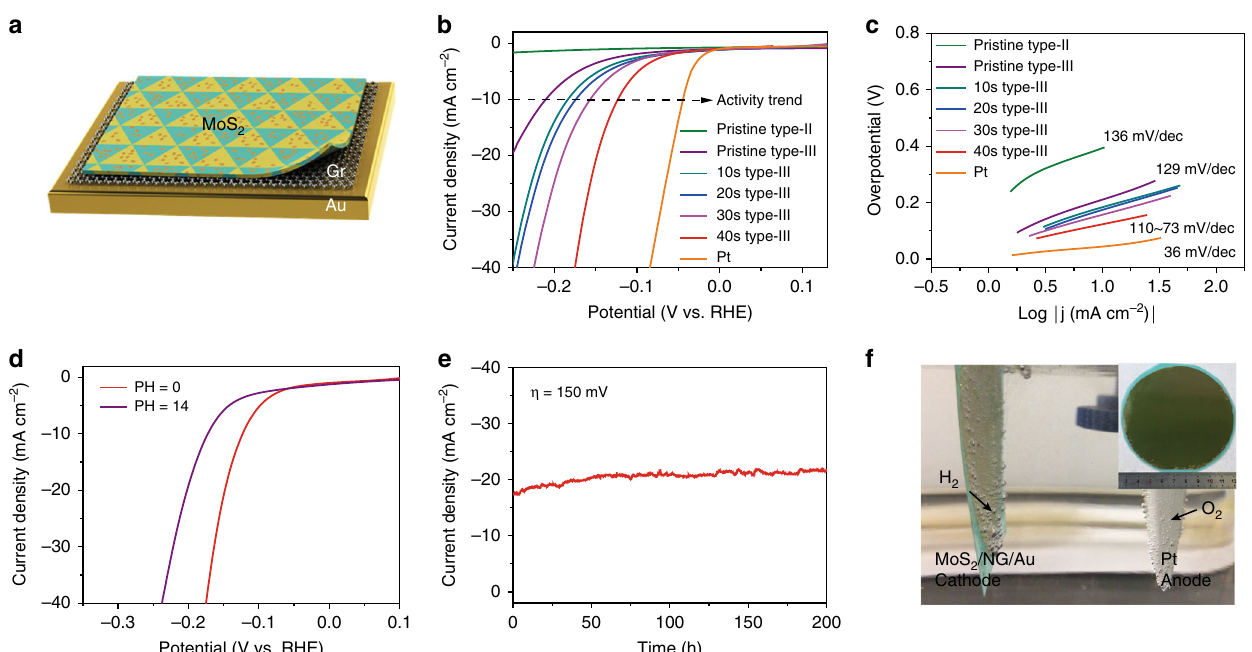
Fig. 4 Multi-hierarchy monolayer MoS 2 catalysts for HER. a Schematic structure of the multi-hierarchy MoS 2 catalysts with both high density of domain and phase boundaries. b Polarization curves for pristine type-II samples, pristine type-III samples, a series of heterophase type-III samples with different phase boundary densities and Pt. c Tafel plots of the corresponding curves in b . d HER performance of a multi-hierarchy MoS 2 catalyst in 0.5-M H 2 SO 4 (red curve) and 1-M KOH (purple curve). e Time-dependent current density curve for a multi-hierarchy MoS 2 catalyst under static overpotential of 150 mV for 200 h. f Demonstration of the catalytic HER activity in 0.5 M H 2 SO 4 from a multi-hierarchy MoS 2 catalyst with a size of 4 inches in diameter.